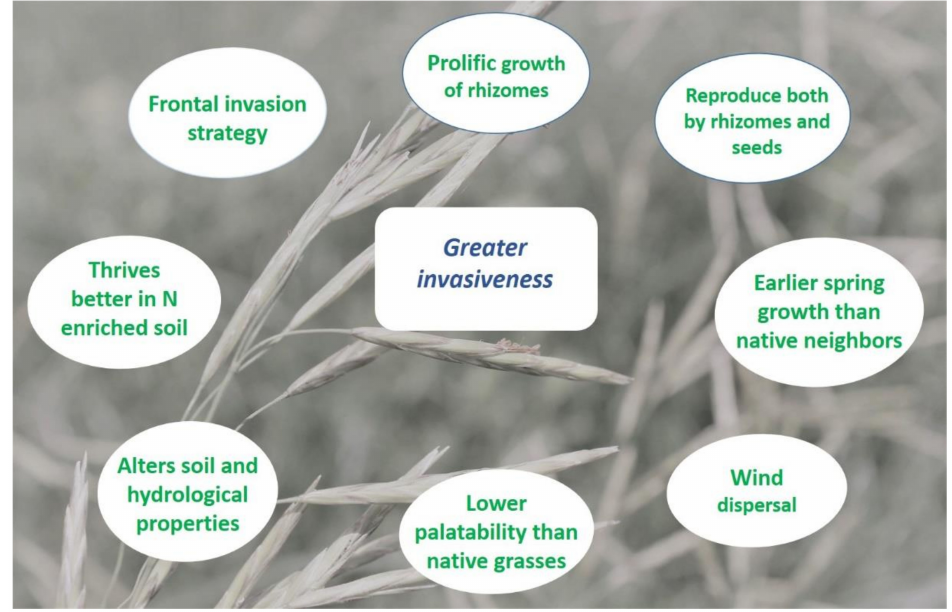
Figure 1. Eco-physiological factors driving the invasiveness in smooth brome. Background image was taken by Edward